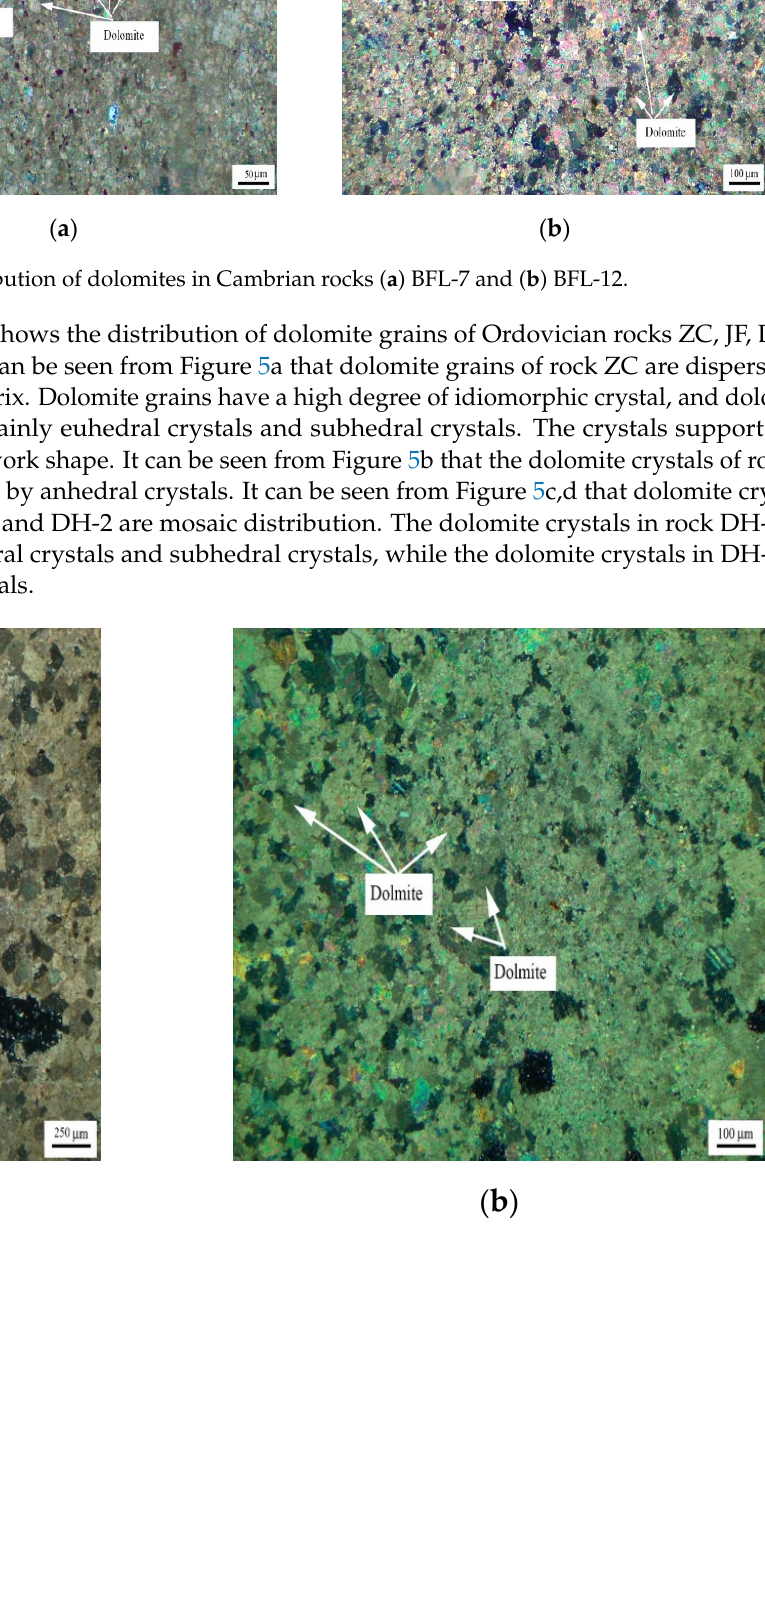
Figure 4. Distribution of dolomites in Cambrian rocks ( a ) BFL-7 and ( b ) BFL-12.